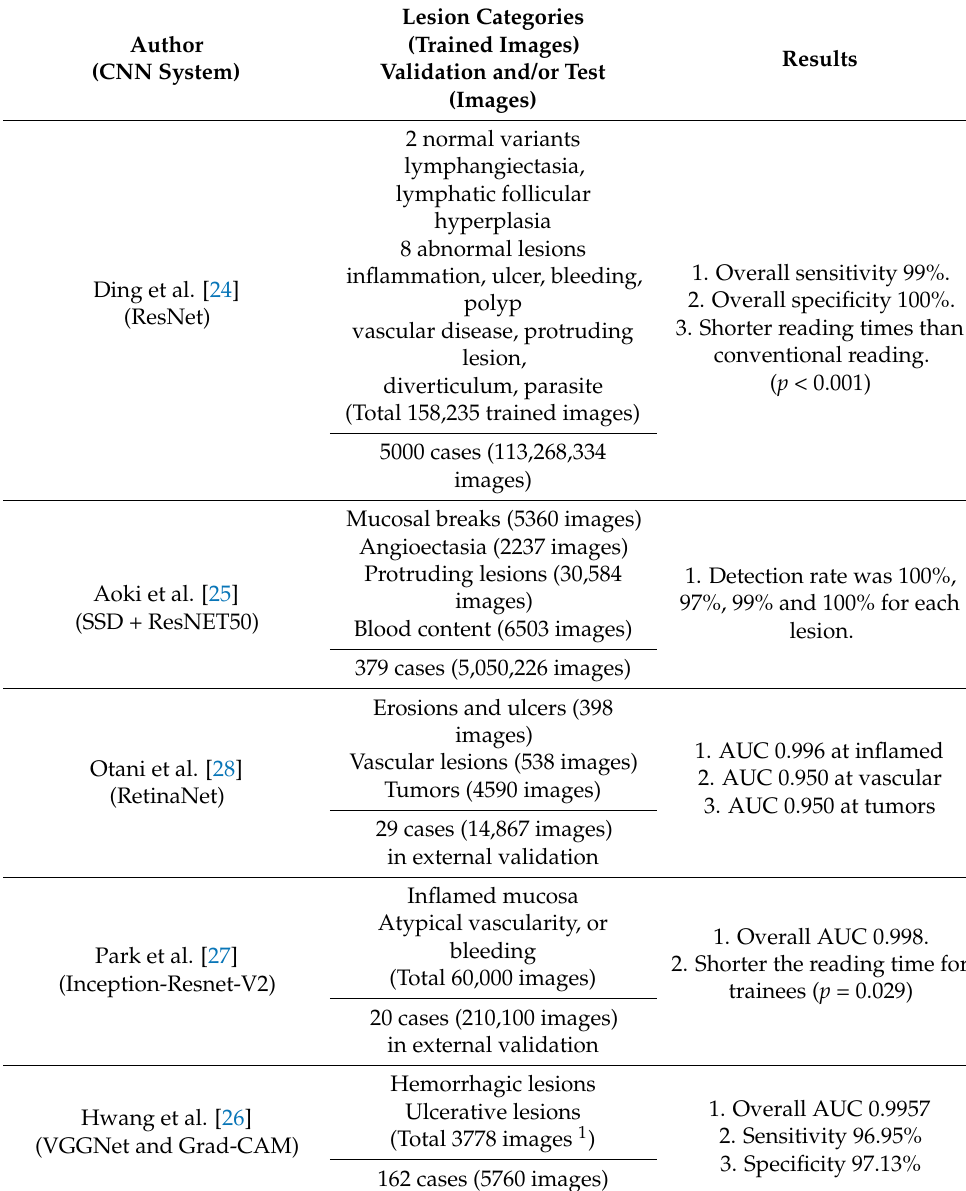
Table 1. Summary of automatic detection of various lesions by using an AI algorithm for reading of small bowel capsule